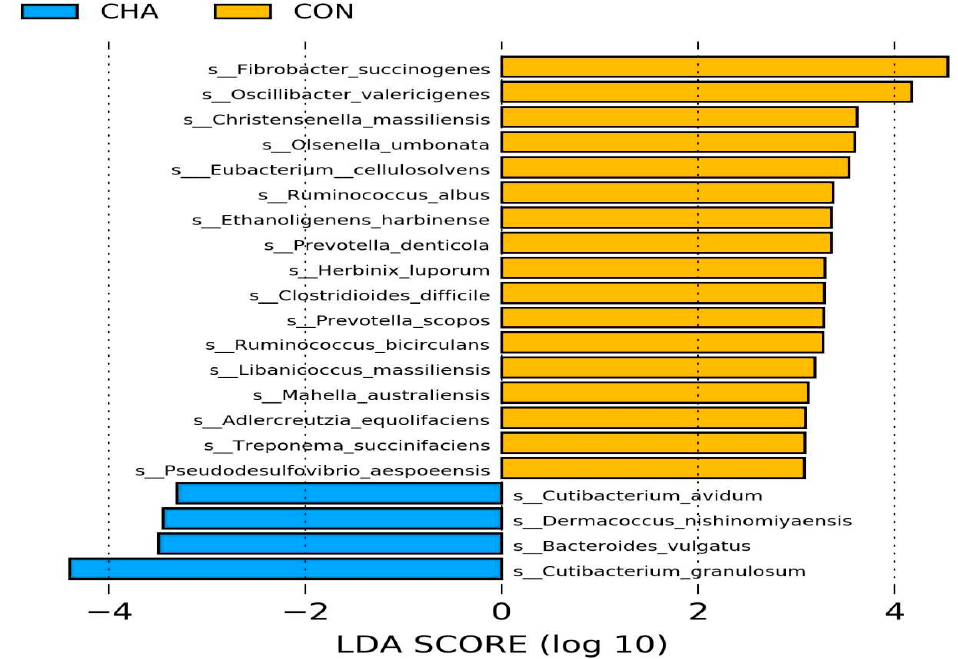
Figure 4. Linear discriminant analysis effect size (LEfSe) of rumen microbiota in beef cattle during the acidosis challenge. CHA = corn-induced acidotic challenge, CON = control (no challenge). The plot indicates the differentially abundant transcriptomic active taxa found by ranking according to their effect size ( ≥ 2.0) at the species level. The taxa enriched in beef cattle fed the control diet (CON) are indicated with a positive score (yellow), and taxa enriched in the corn-induced acidotic challenge treatment (CHA) have a negative score (blue). Only taxa meeting the significant threshold of 2.0 are shown.